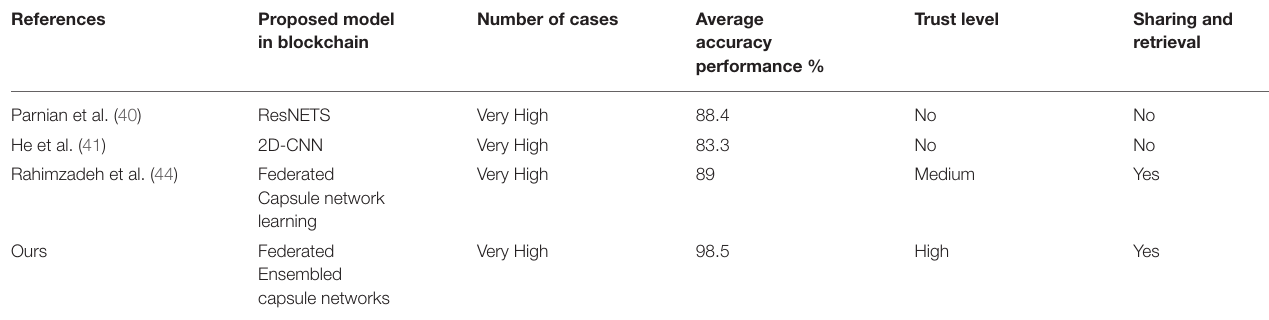
TABLE 6 | Comparative analysis between the blockchain-based learning models for COVID-19 detection of diseases using dataset 2.